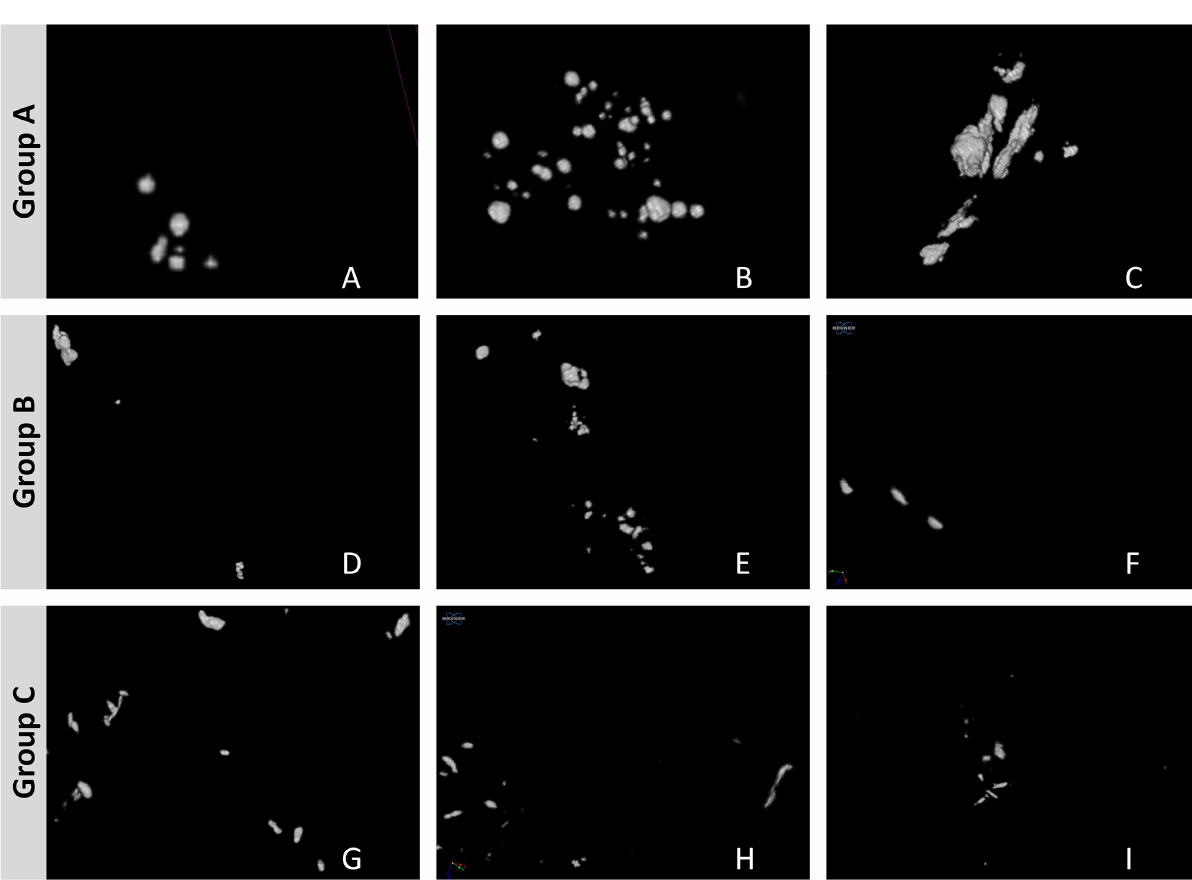
Fig 2. Representative 3D images from different biopsies. Benign(group A: A–C) lesions, unclearbiologicalpotentiallesions(group B: D–F) and malignant(group C: G–I) lesions: A (samplenumber 1, fine pleomorphic),B (samplenumber 6, no suspiciousMC), C (sample number 7, no suspicious MC), D (sample number15, coarse heterogeneous),E (samplenumber 16, fine pleomorphic),F (samplenumber 20, fine linear), G (sample number22, fine linear), H (samplenumber25, fine linear) and I (sample number24, fine pleomorphic). For more details concerning the different samples, comparesample numbers in Tables 1 and